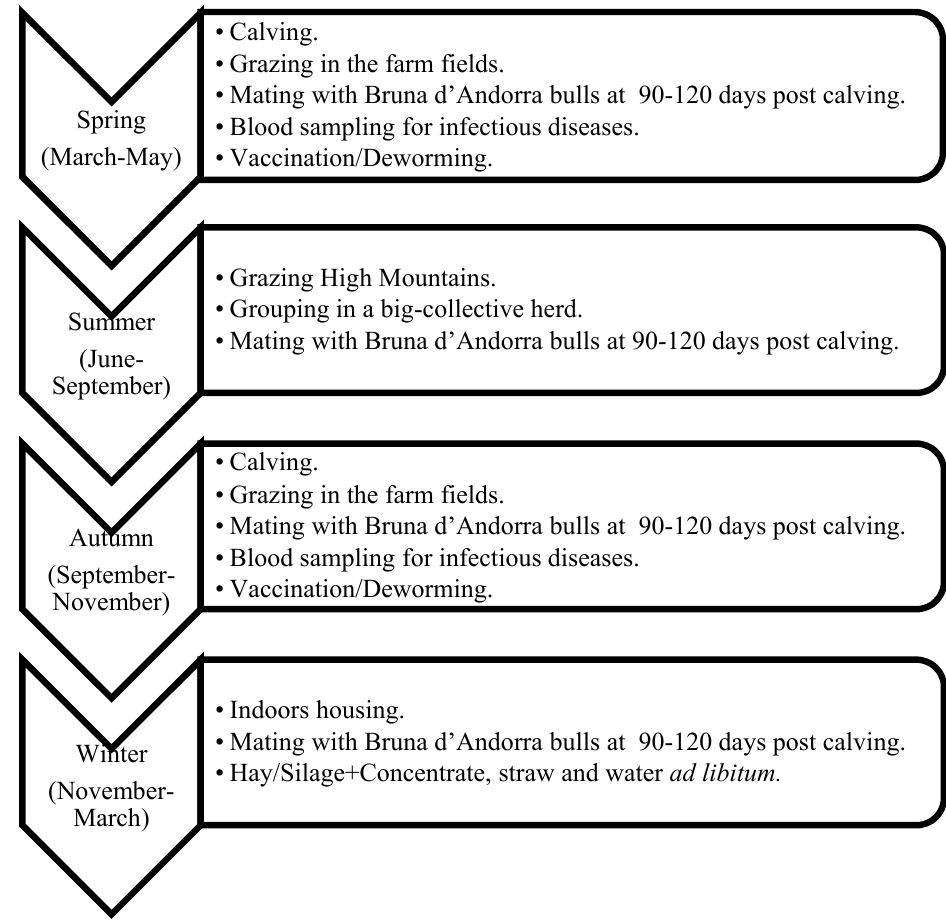
Figure 2. Management, nutritional, and husbandry protocols used with adult cows (>1 calving).